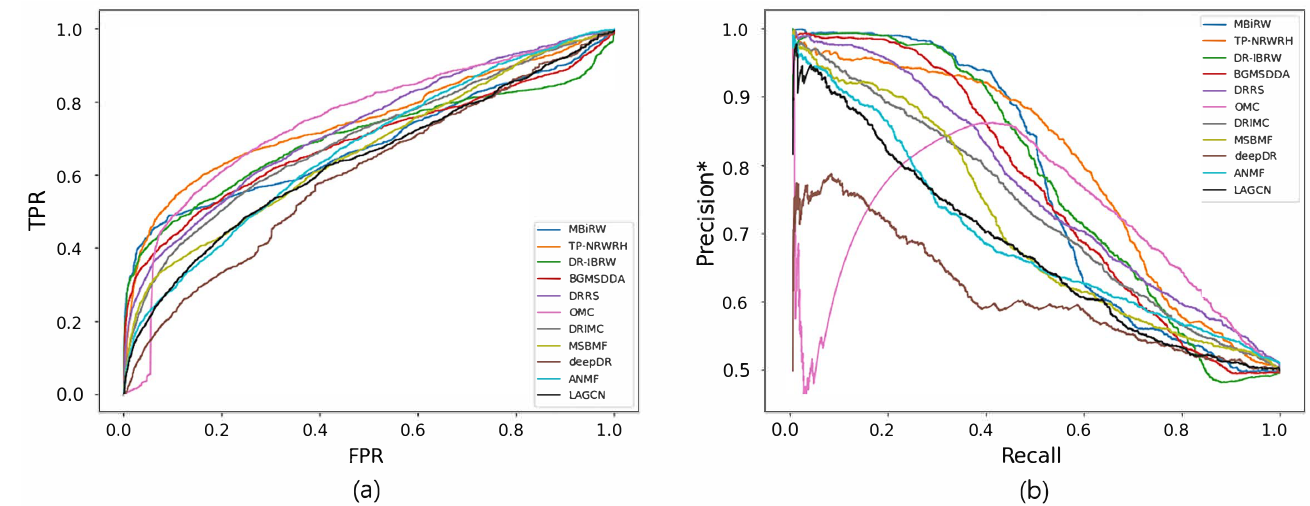
Figure 3. ROC curve ( a ) and precision*-recall curve ( b ) of drug-disease association prediction results for new diseases with network-CS.